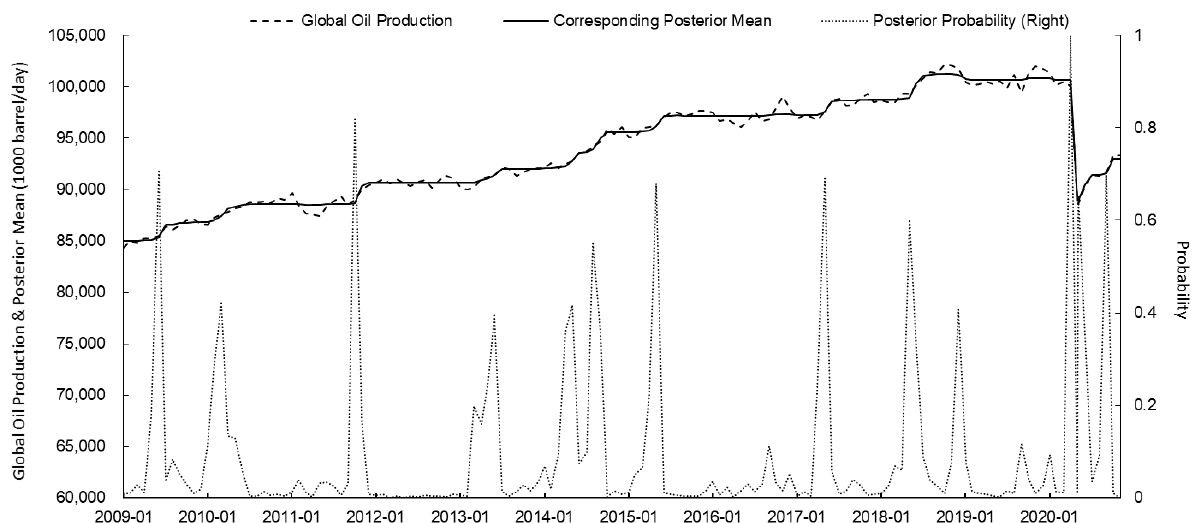
Figure 2. PPM calculation results of the US dollar index and corresponding posterior mean and posterior probability since 2009 (source: Intercontinental Exchange).